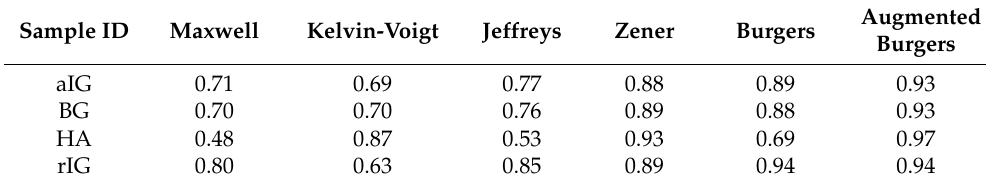
Figure 6. Schematic illustration of the Burgers rheological model.